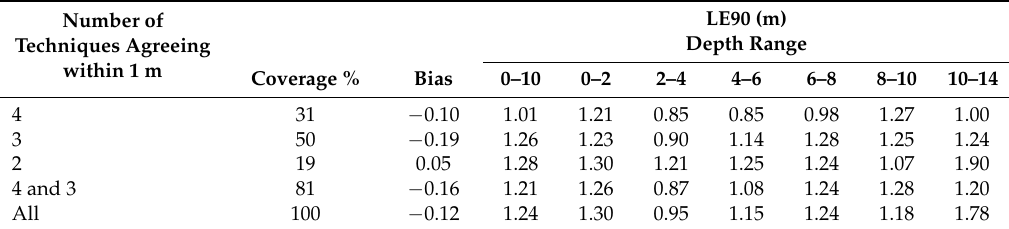
Table 5. Accuracy assessment results for the multi-approach